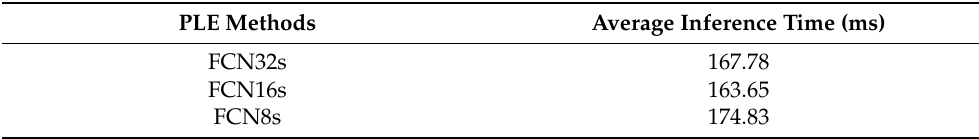
Table 3. The robustness test metrics in the four scenes. Table 3. The average inference time of a power line image by using different